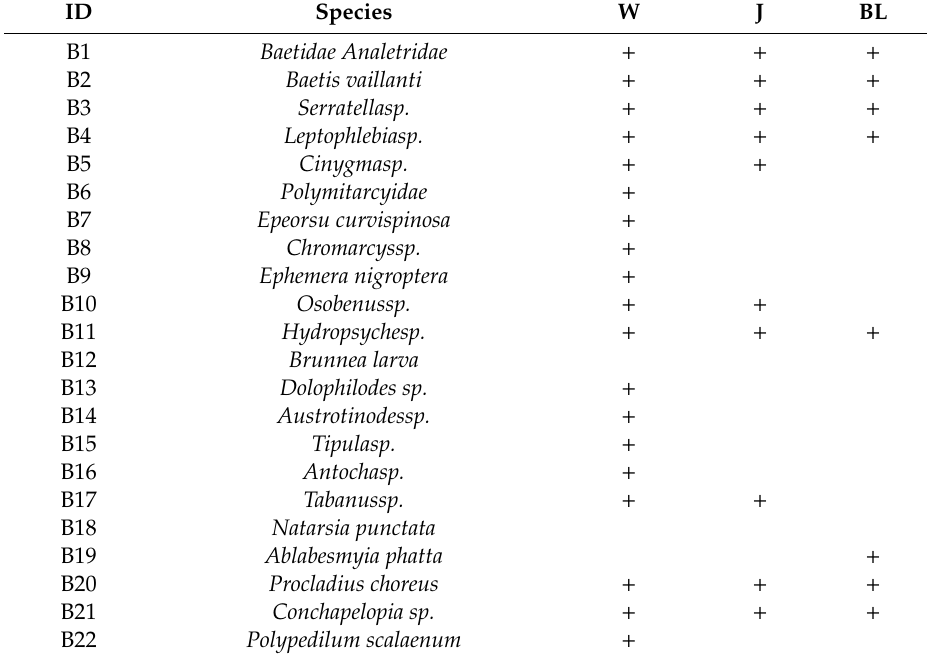
Table A2. The list of macroinvertebrate species in Wei River